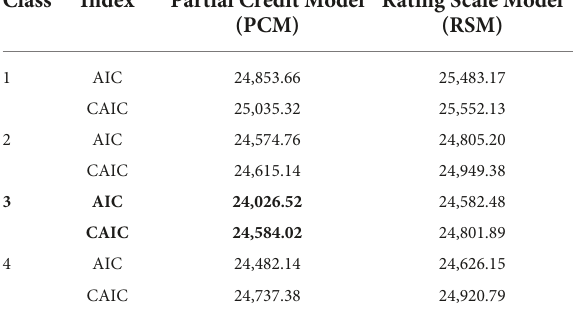
TABLE 1 Information criteria: The AIC and CAIC values for the PCM and